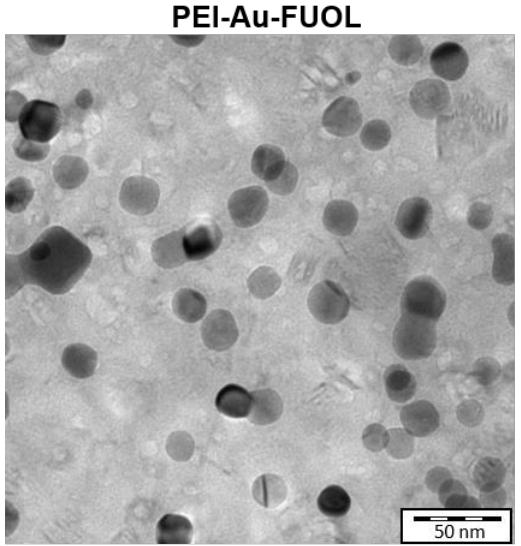
Figure 2. The surface of polyethylenimine incorporating gold nanoparticles and fullerenol (PEI-Au- FUOL) in transmission electron microscopy.